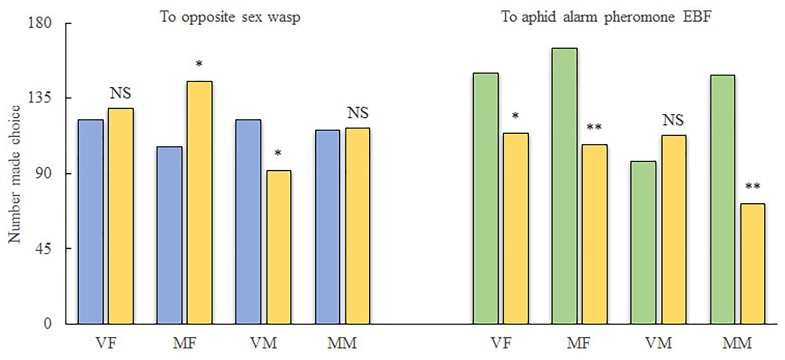
Behavioral investigation of the response of Aphidius gifuensis to EBF as well as to wasps of the opposite sex. VF, virgin female; MF, mated female; VM, virgin male; MM, mated male; ∗P < 0.05; ∗∗P < 0.01; NS, not significant. A total of 300 wasps were tested for each treatment. Yellow, number of wasps that chose the empty control arm; Blue, number of wasps that chose the treatment arm containing wasps of the opposite sex; Green, number of wasps that chose the treatment arm containing EBF.